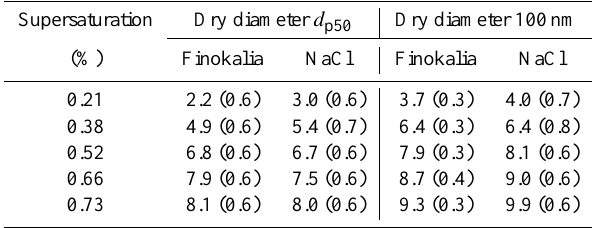
Table 3. Average droplet size (standard deviation) measured by the optical particle counter (µm) for different supersaturations. Results shown for Finokalia and NaCl calibration aerosol with dry particle diameter of size d p50 and